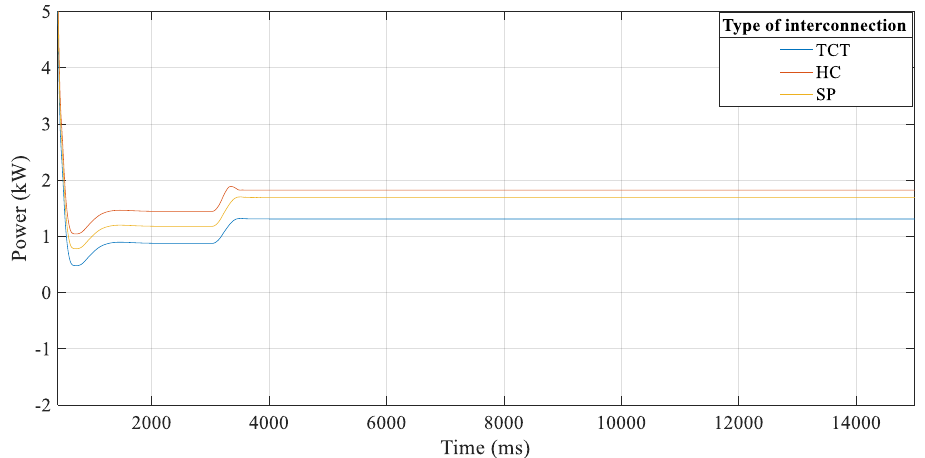
Energies 2019 19 of 25 Figure 23. Impact of non-uniform shading fault ‘F3′ on power grid (monocrystalline PV). Figure 24. Impact of non- uniform shading fault ‘F3′ on power grid (thin-film PV). Multiple faults under severe non-uniform shading (F4) reduce tracked MPP from 5.2 kW to 1.4 kW,1.8 kW and 1.62 kW in TCT, HC and SP, respectively, in monocrystalline PV as shown in Figure